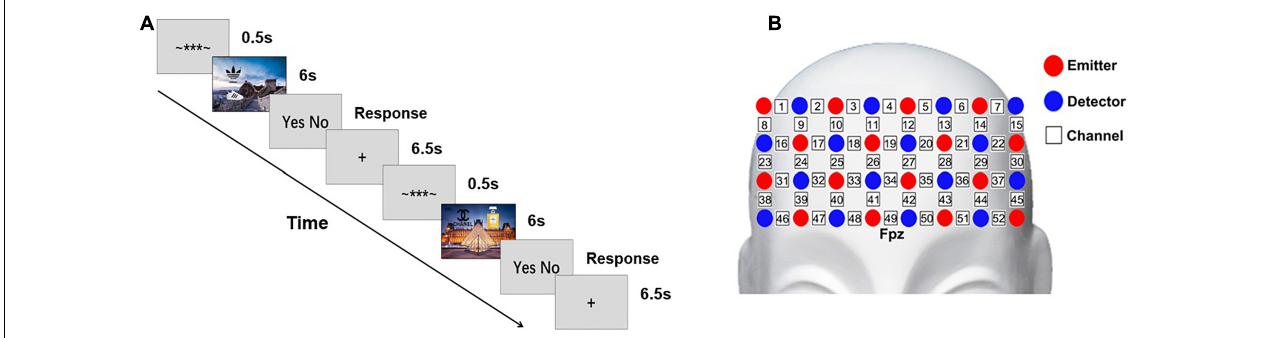
FIGURE 1 | Scheme of the experiment. (A) The paradigm of the experiment. (B) The configuration of the fNIRS probes.